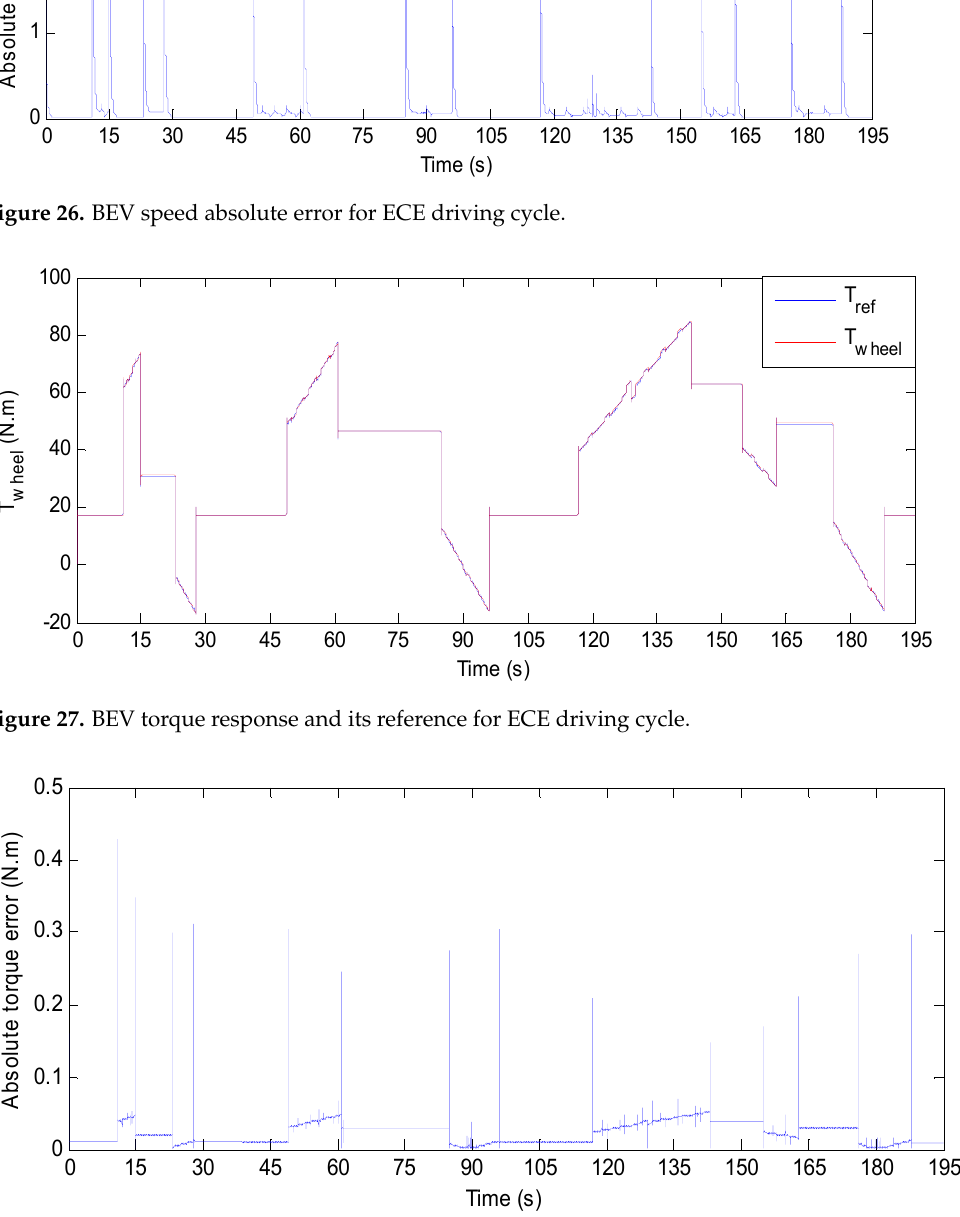
Figure 28. BEV speed absolute-torque error for ECE driving cycle.